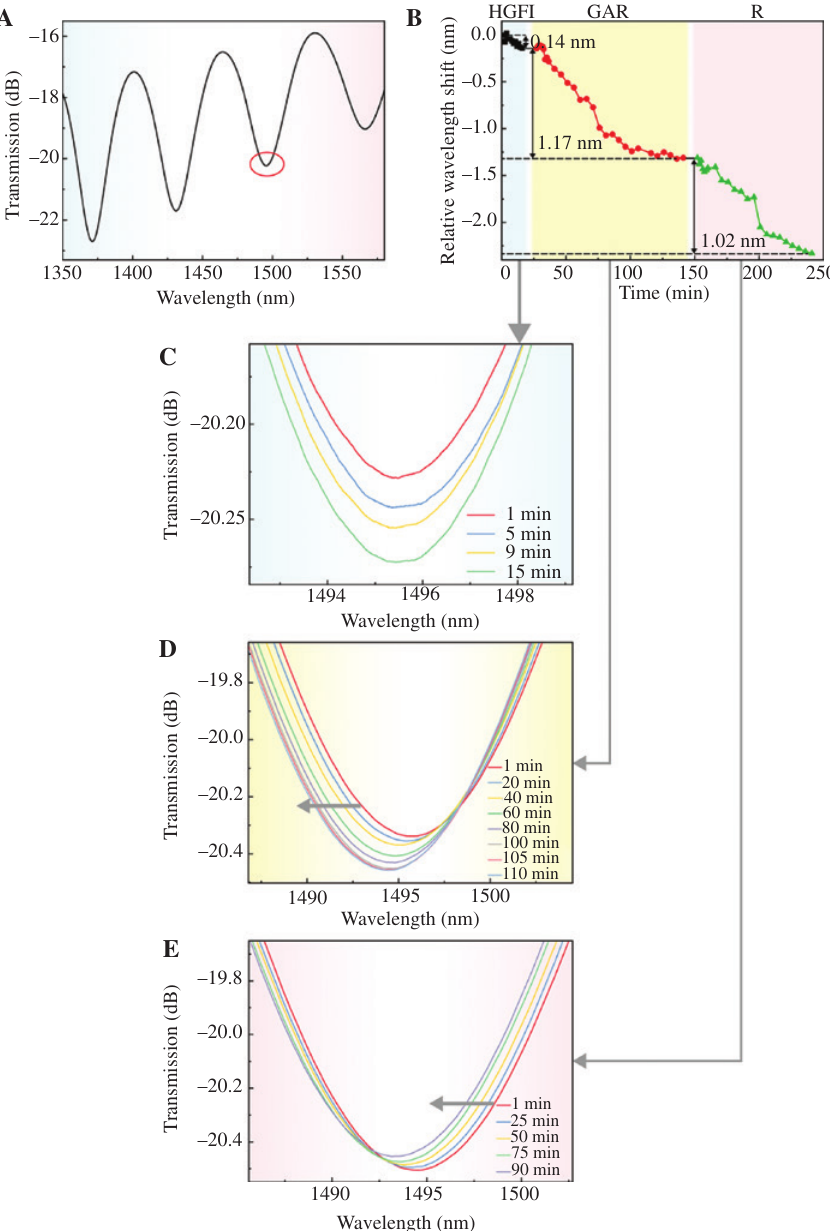
Figure 7: Detection of R antigens. (A) Initial transmission spectrum of the S-tapered fibre immersed in HGFI. (B) Real-time relative wavelength shift in response to HGFI modification and antibody–antigen reaction. (C–E) show typical spectra of HGFI modification, GAR immobilisation, and R detection,